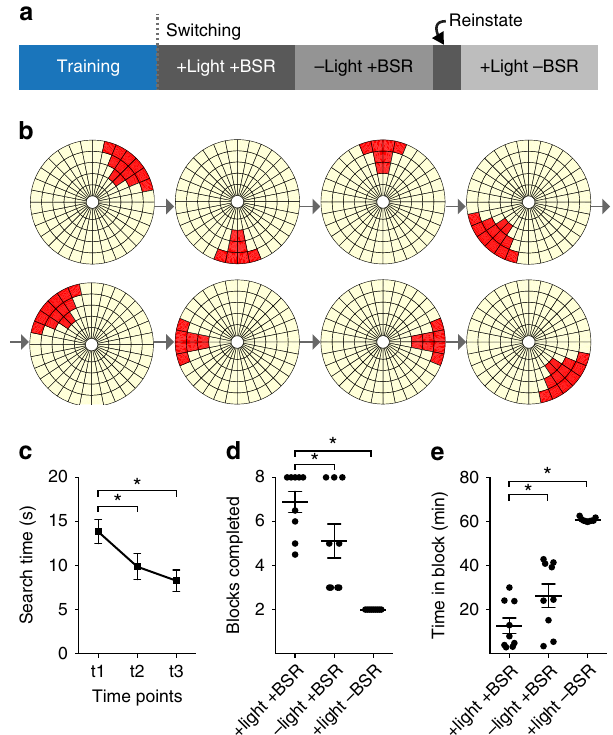
Fig. 6 Learning in a joystick task of action discovery was impaired by manipulation of reward signals. a Schematic outline of task